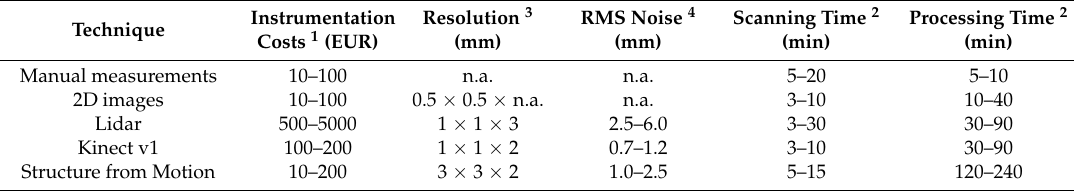
Table 2. Comparison of performances of main 3D techniques, elaborated from the present study and from other works